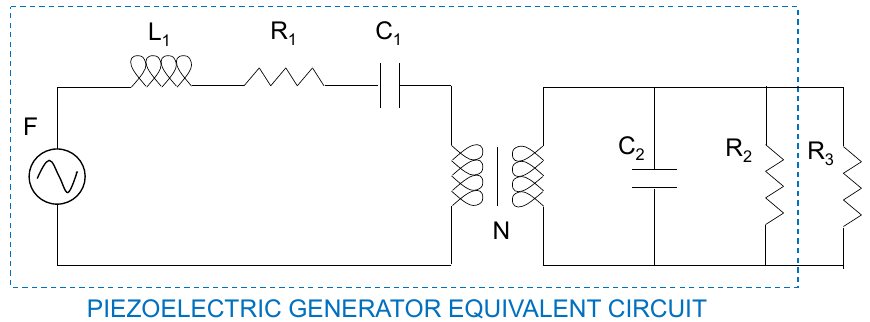
Figure 3. Piezoelectric generator equivalent circuit used to obtain the output voltage in a resistive load situation.